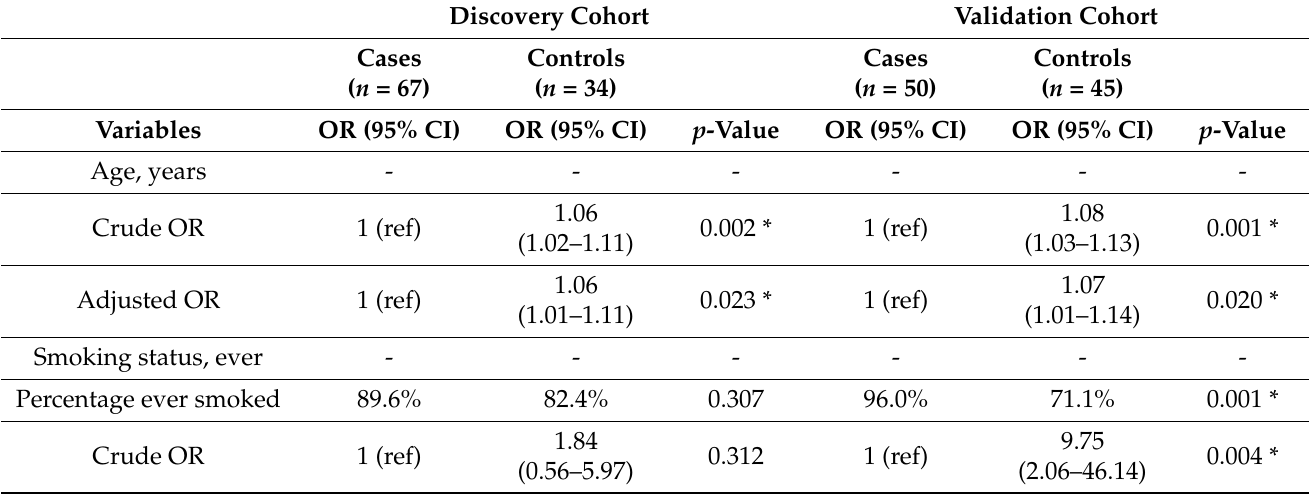
Table 4. Multiple logistic regression model developed on data from the Discovery cohort and subsequently applied to data from the Validation cohort. The model included data on 101 and 95 participants, respectively, from the Discovery and Validation cohorts. * Statistically significant impact.